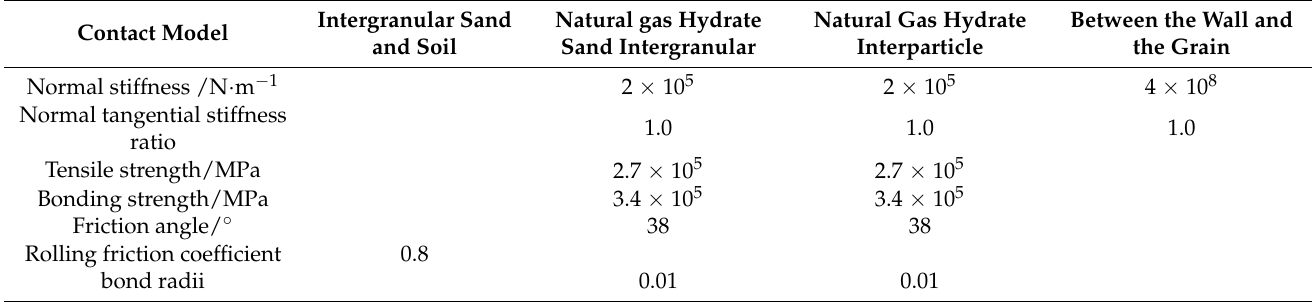
Table 2. Characteristic parameters of parallel bond model and rolling resistance linear contact